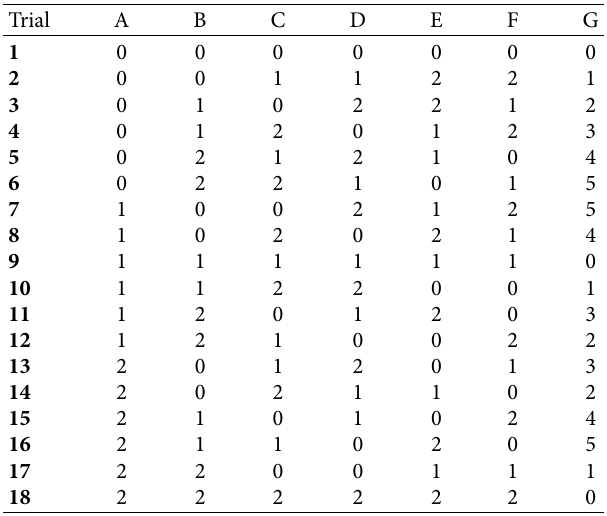
Table 3: L18 orthogonal array suitable for particle mass optimi- zation algorithm.